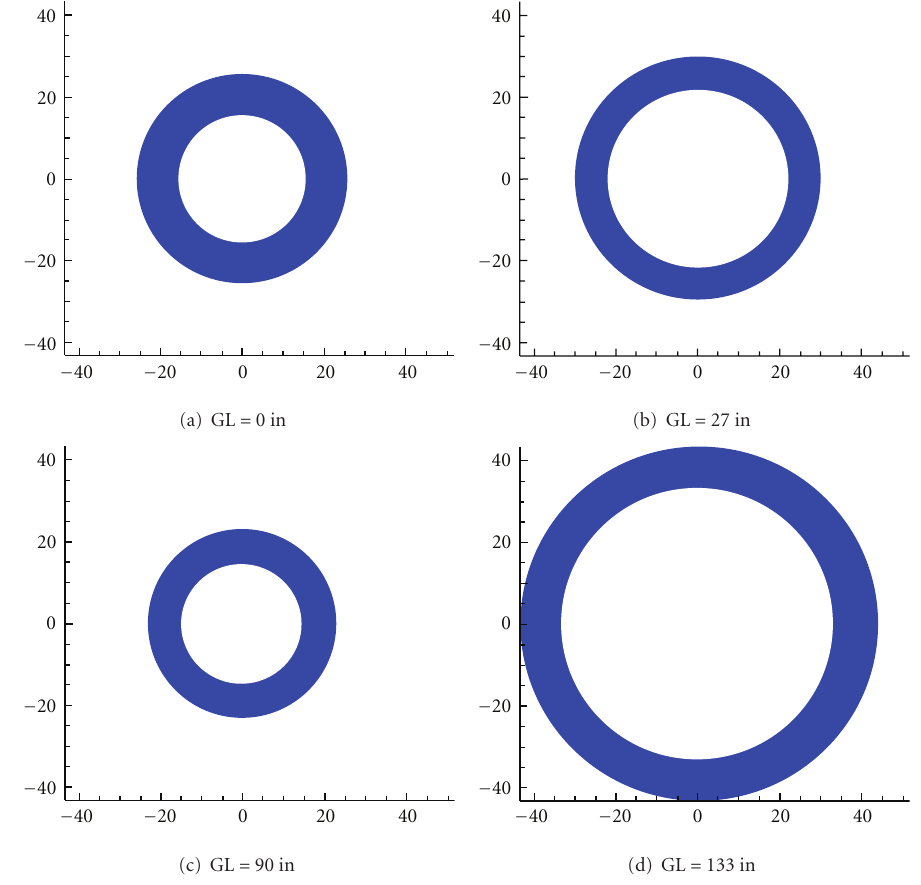
Figure 13: Optimized grain cross section for neutral burning CP